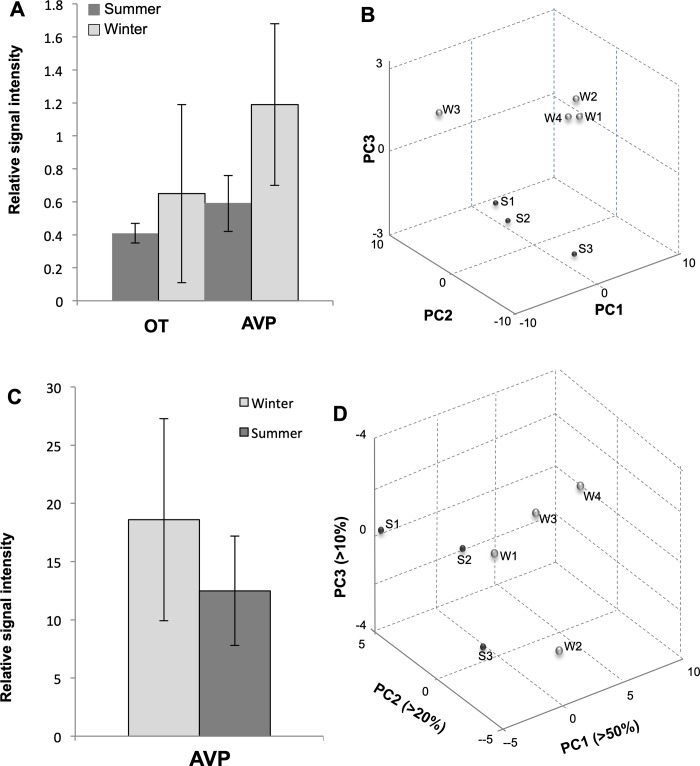
Seasonal peptide level change in camel supraoptic nucleus and neurointermediate lobe.(A) Signal intensity changes of select peptide ions in camel supraoptic nucleus at different seasons. Labels: AVP, arginine vasopressin; OT, oxytocin. (B) Principal component analysis plot for the first three principal components (PC) allows discrimination between seasonal supraoptic nucleus samples based on peptide profile change, S1-S3, summer samples; W1-W4, winter samples, W3 samples is an incorrectly isolated sample. (C) Signal intensity changes of AVP ions in camel neurointermediate lobe at different seasons. Labels: AVP, arginine vasopressin. (D) Principal component analysis plot for the first three principal components (PCs) allows discrimination between seasonal neurointermediate lobe samples based on peptide profile change. S1-S3, summer samples; W1-W4, winter samples.